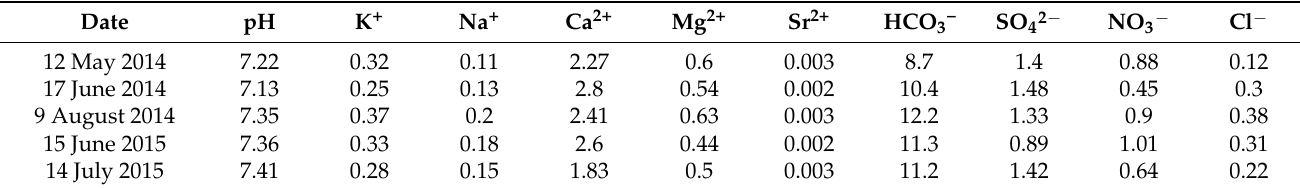
Table 2. Previous hydrochemical data compilation of rainwater during rainy seasons in the study area (unit: mg · L − 1